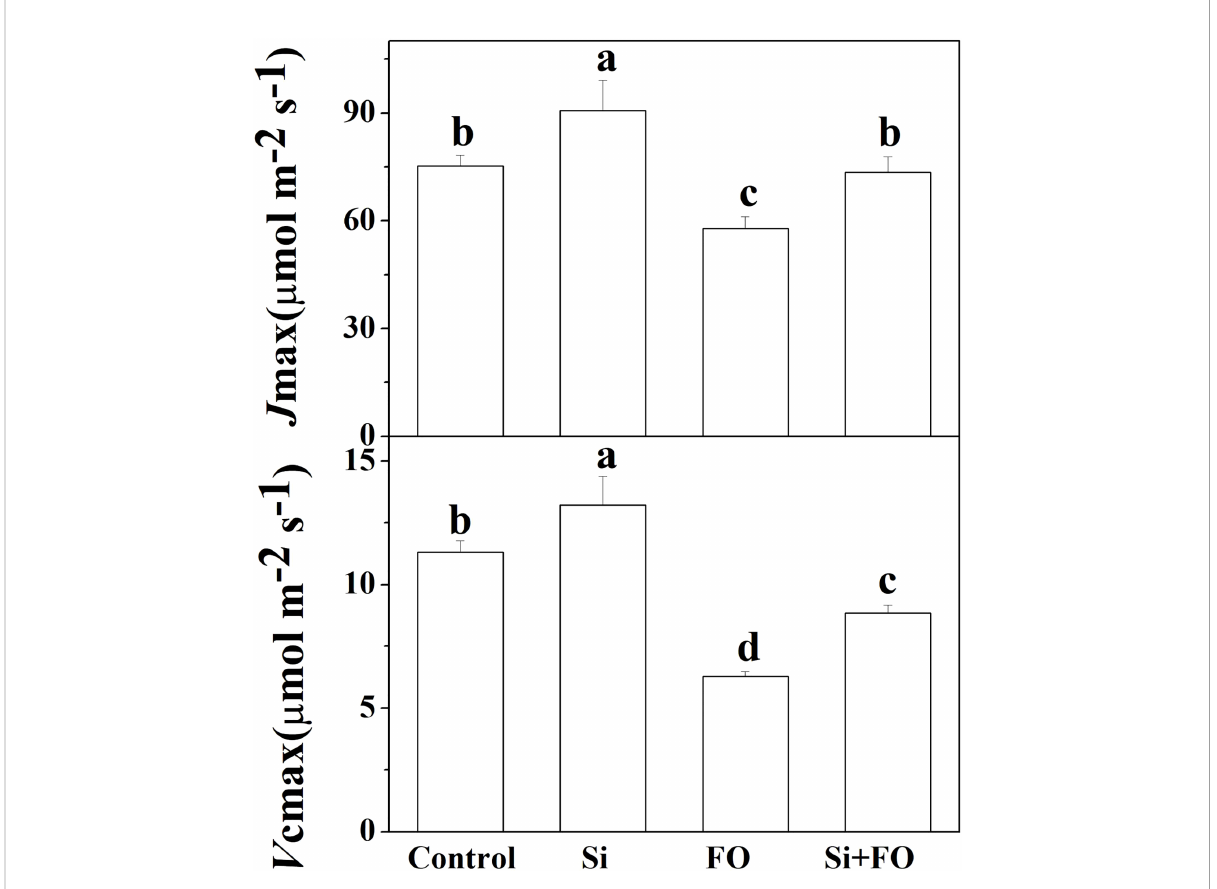
FIGURE 6 Effects of exogenous silicon application on J max and V cmax of cucumber leaves. Means denoted by the different lowercase letters are signi fi cantly different according to Tukey ’ s test ( P ≤ 0.05); the mean represents the average of three replicates ± standard deviation (SD). Control: plants were irrigated with sterilized water; Si: plants were irrigated with exogenous silicon (3 mmol·l -1 Si); FO: plants were only inoculated with Fusarium ; Si+FO: plants were irrigated with exogenous silicon followed by inoculation with Fusarium.